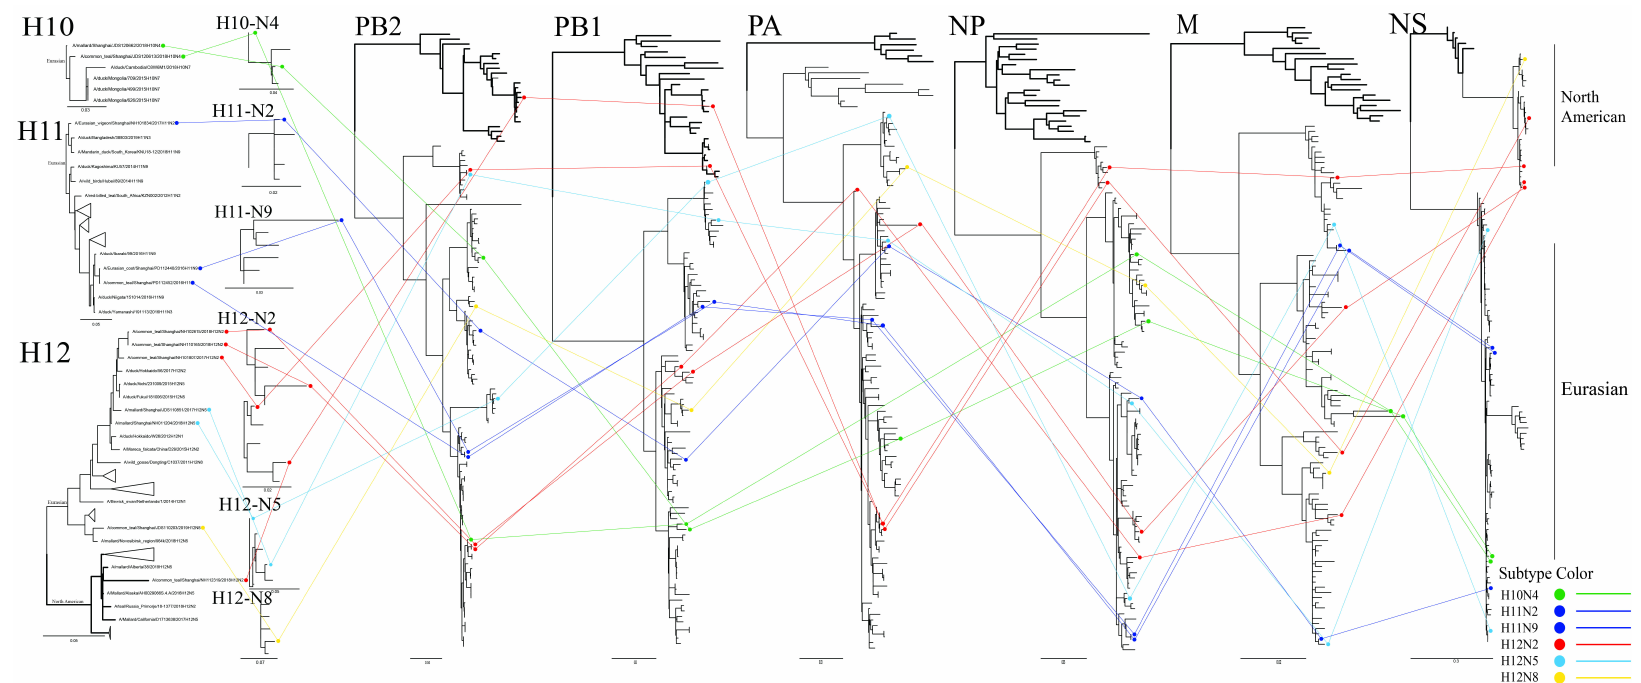
Figure 5. Genomic reassortment of H10–H12 isolates. ML trees contain all sequences generated in this study. Isolates and connecting lines are colored: H10—green; H11—dark blue; H12N2—red; H12N5—light blue; and H12N8—yellow. North American branches are shown in